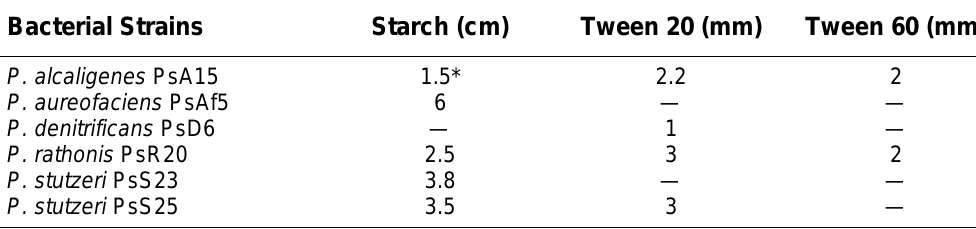
Diameter of hydrolytic zone in cm.